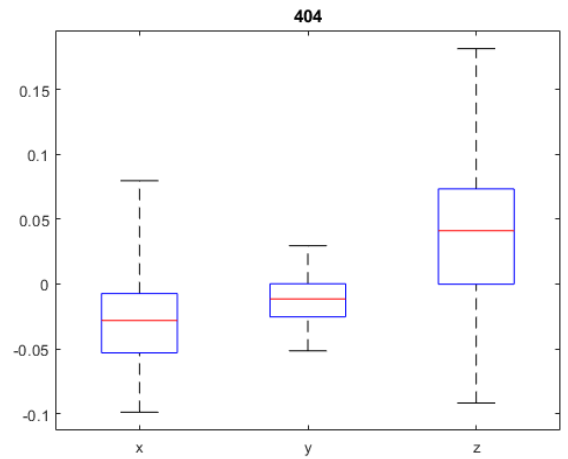
Figure 13. Boxplot for the x , y and z components of residuals, for the point 404.